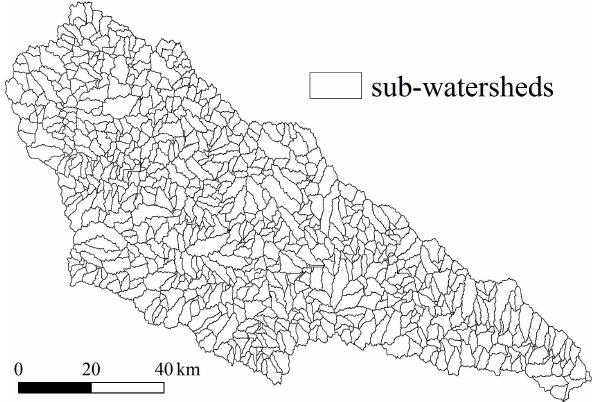
Fig. 5. Spatial distribution of the stream elevation plane in the Yanhe watershed.